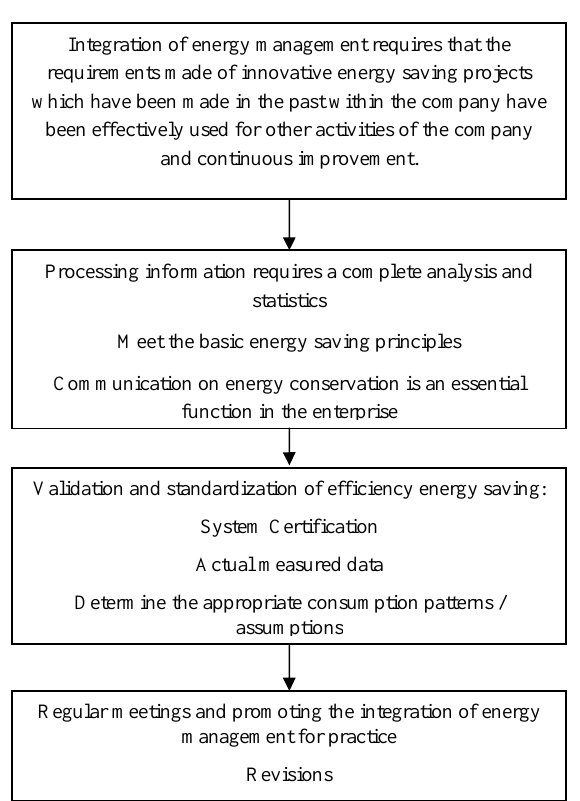
Figure 2 – Principles and procedures within evaluating a model integrating energy